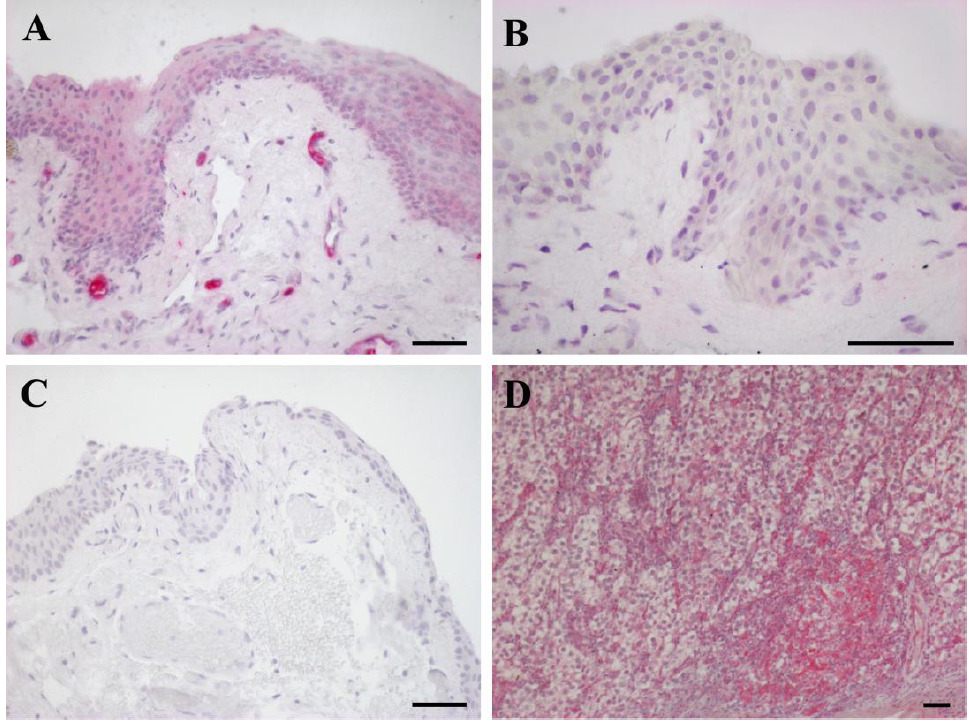
Figure 3. IGF-1R IHC expression: ( A ) pterygium; ( B ) conjunctiva; ( C ) pterygium, negative control ( D ) human seminoma, positive control. Counterstained with Carazzi hematoxylin. ( A – D ) Scale bar= 25 µm.